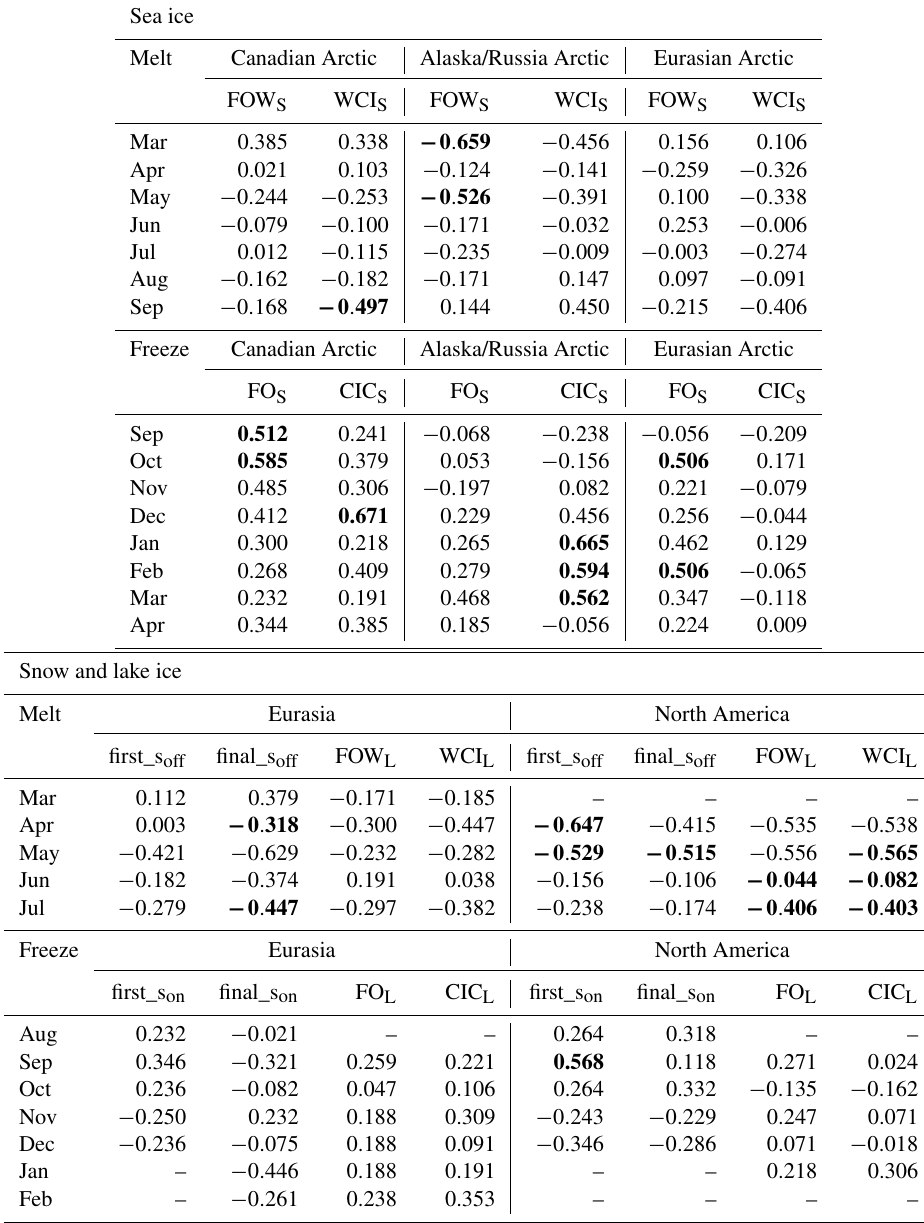
Table 5. Regional Spearman rank correlations ( ρ ) for snow and ice phenology dates and monthly downwelling longwave radiation (APP-x) from 2004–2019. For sea ice, Canadian Arctic includes Baffin Bay, Hudson Bay, and the CAA; Alaska/Far East Russia includes the Beaufort, Chukchi, and Bering seas; and Eurasian Arctic includes the East Siberian, Laptev, Kara, Bering, and Greenland seas (see Fig. 1). Months were selected for each phenology parameter based on mean phenology dates in Fig. 3. Bold represents statistically significant correlations at the 95% confidence